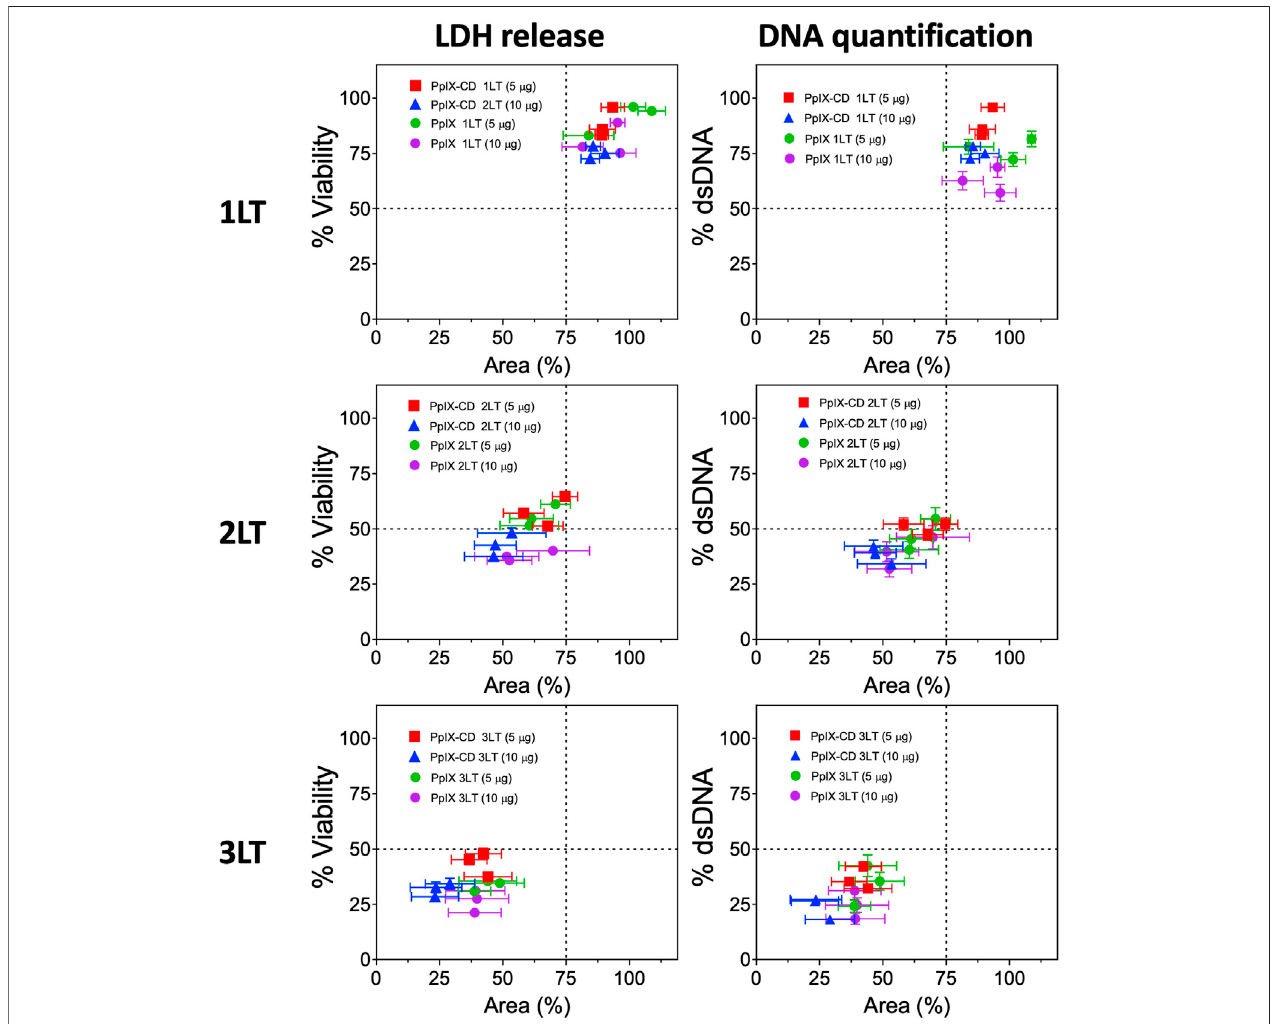
FIGURE5 | PDT treatment combinations leadto varying degrees of spheroid damage. PpIX and PpIX-CD show similar reductions toviability and spheroid area as light treatments (LT) were increased. Light fractionated treatments (2LT and 3LT) caused greater damage to spheroids, reaching around 25% viability and area in comparison tosingle lightexposure (1LT). Each point represents aspheroid group withdifferent PDT conditions ( N (cid:1) 3, n (cid:1) 3). Similar combinations (e.g., PpIX 3LT 5 µg and 10 µg) could not be differentiated.